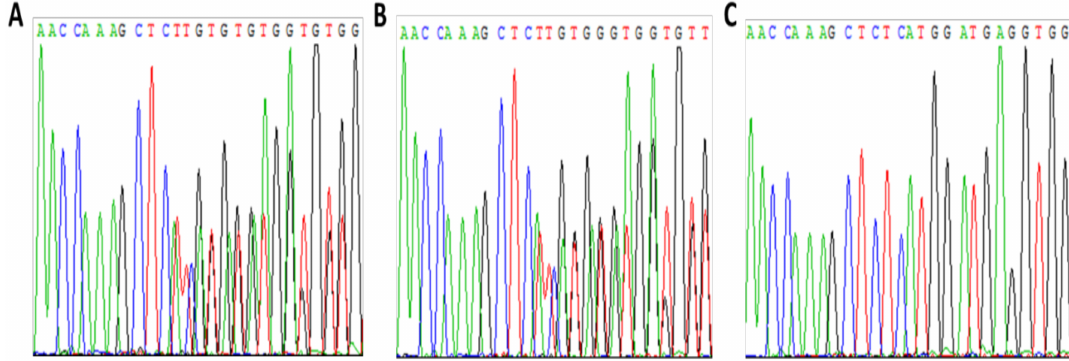
Figure 1. Analysis of patient 1 and her family members for the PGK1 mutation c.1061_1062delCT. ( A )—patient 1, ( B )—mother, ( C